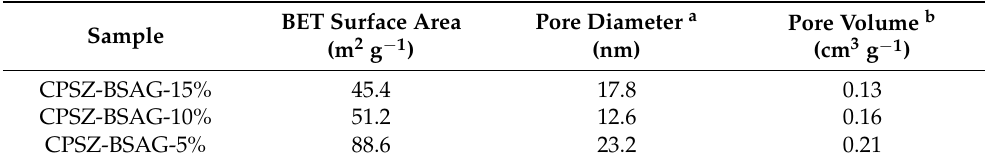
Figure 4. ( a ) Nitrogen adsorption–desorption isotherm and ( b ) pore size distribution of ceramic aerogels (pyrolysis at 1000 °C) prepared with different solution ratios. Table 2. Pore structure data (characterized by the BET method) of ceramic aerogels (pyrolyzed at 1000 °C).